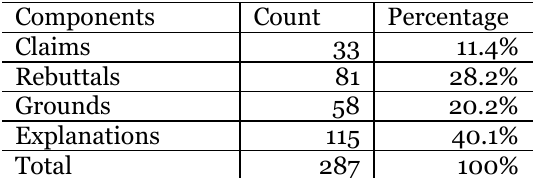
Structural Components of Individual Argumentation (Semantic